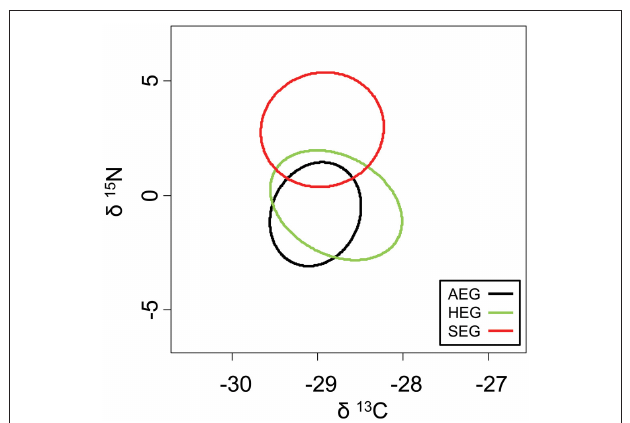
FIGURE 5 | Isotopic niches of the plant samples from the three study regions based on standardized